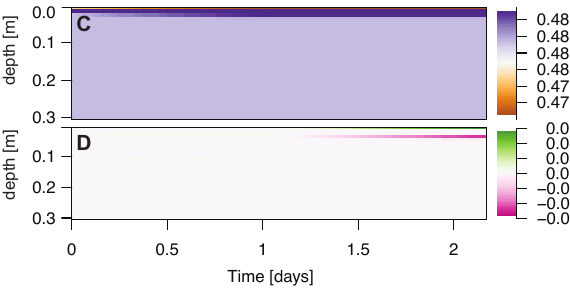
Figure 1. Evolution of temperature (a) and total water content (c) for simulations with a time step of 1s. The difference to the solu- tions with a time step of 1h are also shown for temperature (b) and total water content (d) based on subtracting the hourly solution from the 1s